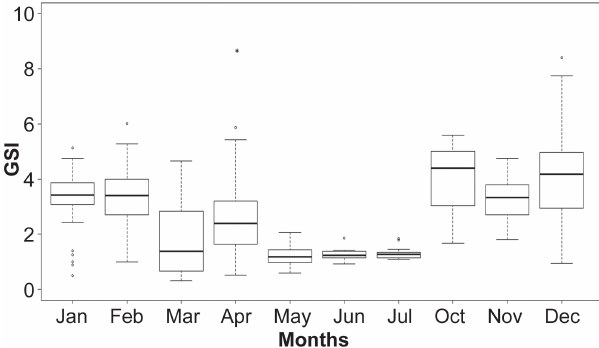
Fig. 7. Monthly variation of the gonadosomatic index (GSI), based on an annual cycle. Boxplots with median, 75th percentile and 25th percentile. Bars denote standard deviation. Open circles= outlier values; asterisk= extreme outliers.